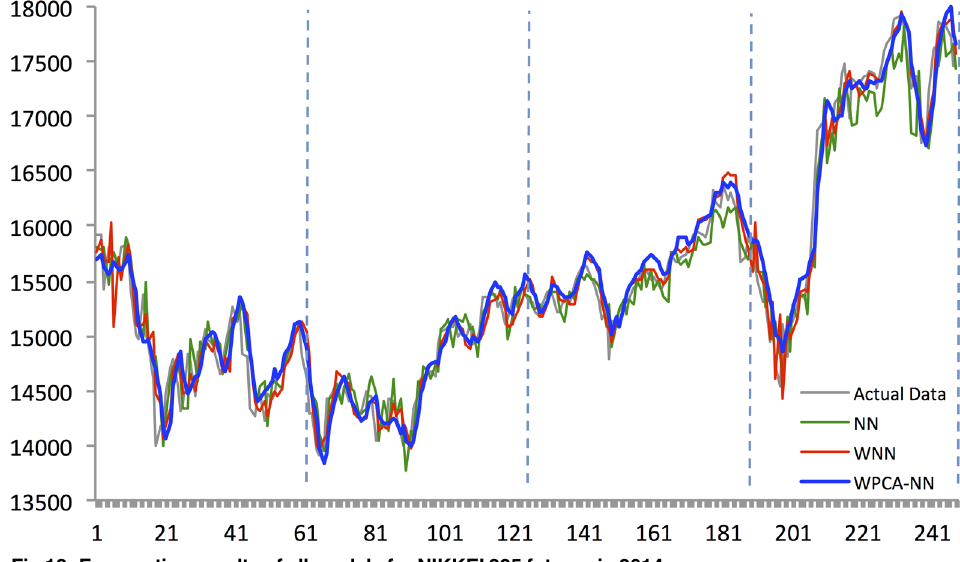
Fig 12. Forecasting results of all models for NIKKEI 225 futures in